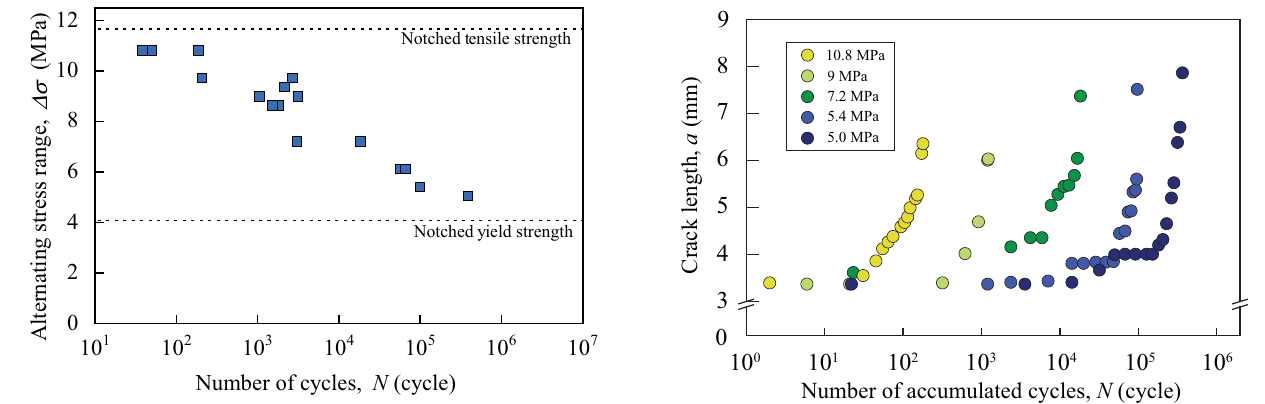
Fig. 6 Crack extension during fatigue loading. Digital image correlation was used to determine the crack length ( a ) as a function of the number of accumulated cycles ( N ). The legend indicates the alternating stress range for each specimen ( Δ σ ). The error bars were smaller than the symbols used to denote the crack